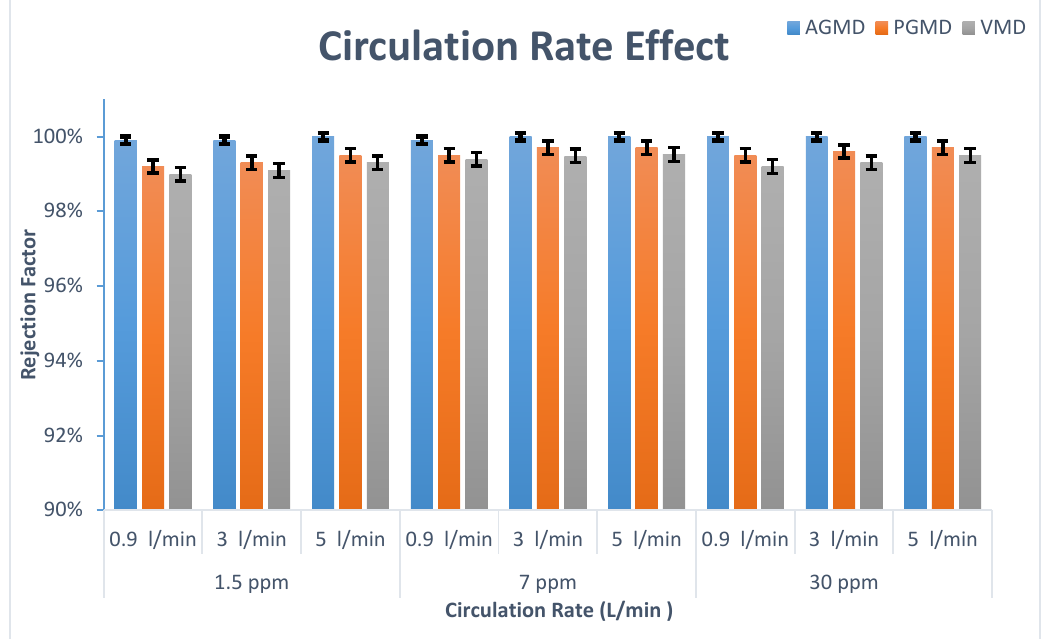
Figure 3. Impact of feed circulation rate and initial boron concentration on boron rejection for Air Gap Membrane Distillation (AGMD), Permeate Gap Membrane Distillation (PGMD), and Vacuum Membrane Distillation (VMD).